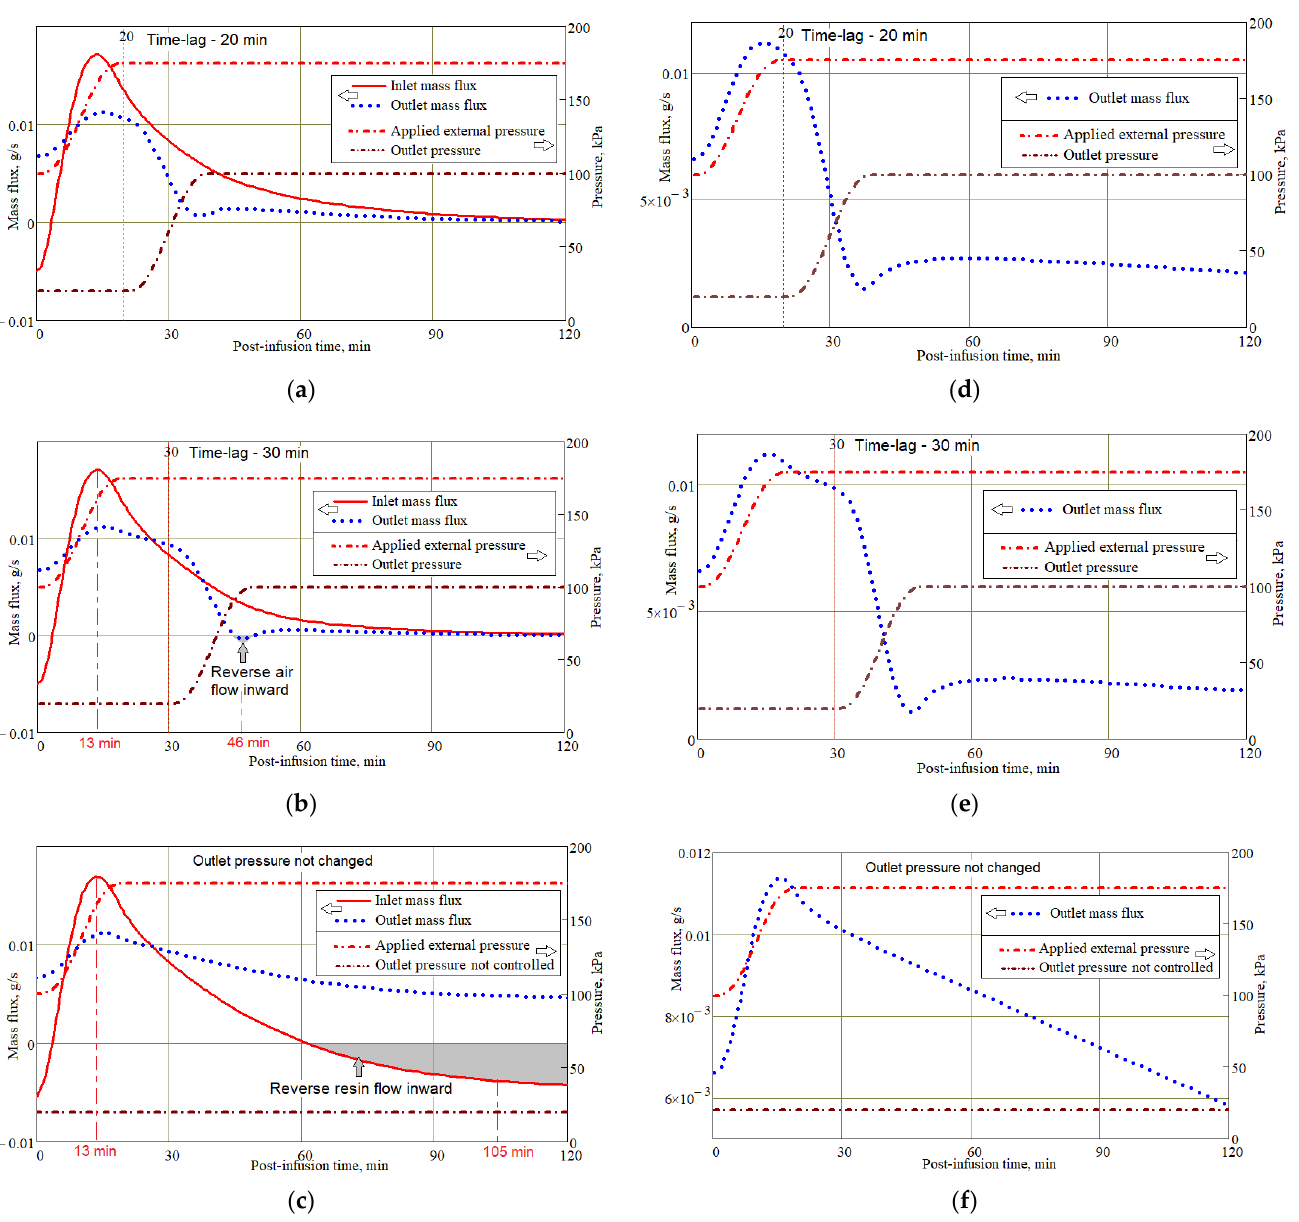
Figure 11. Time dependences of resin mass flows through the inlet and outlet for the first ( a – c ) and second ( d – f ) scenarios of post-infusion exposure, combined with graphs of changes in external compressive pressure and outlet pressure. Diagrams ( a ) and ( d ) correspond to the time-lag of the moment of pressure increase at the outlet of 20 min, ( b ) and ( e )—30 min, a constant outlet pressure of 20 kPa—diagrams ( c ) and (f ).